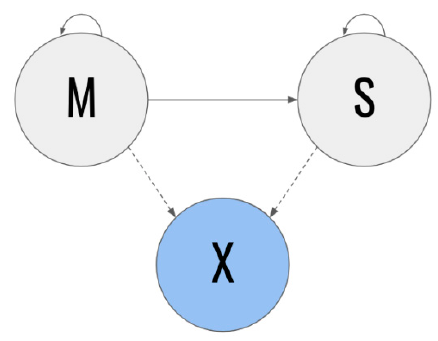
Figure 2. Model based on Markov hidden chains.